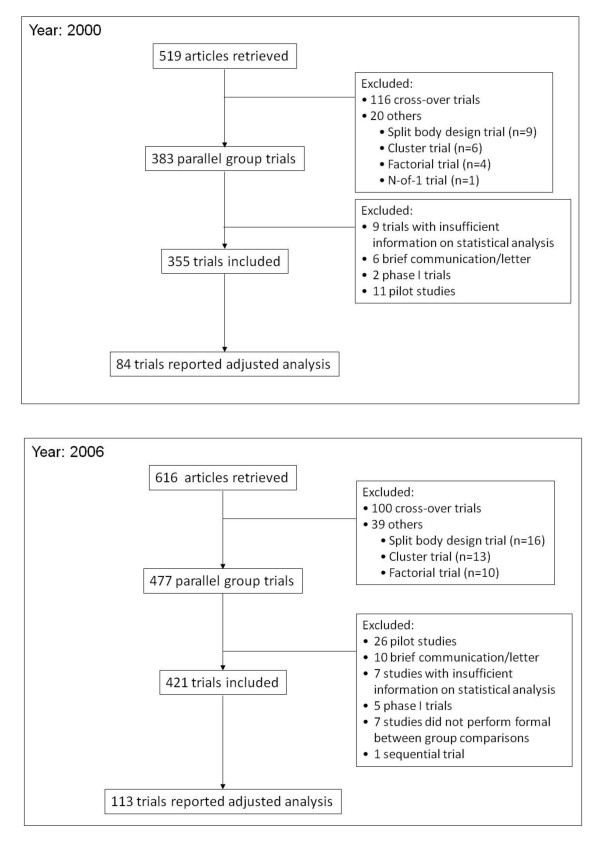
Flowchart diagram of articles retrieved and included in the review.